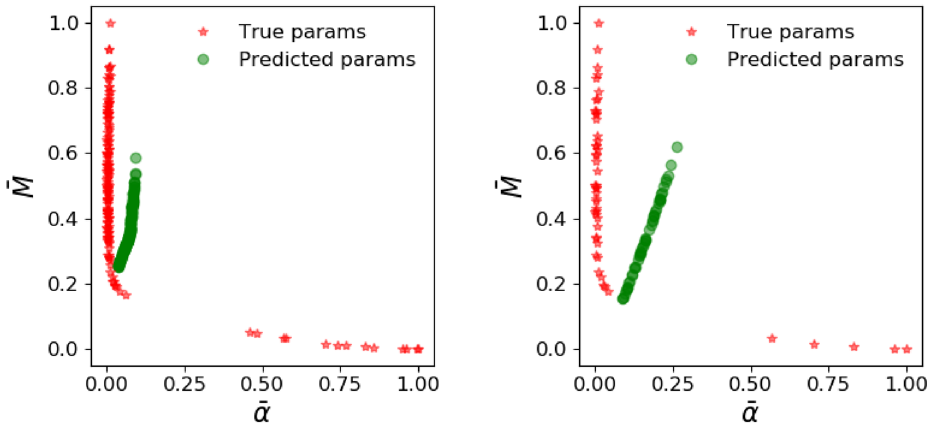
Figure 9. Parameter prediction from the ANN with production loss function (8) before (left) and after (right) transfer learning. The training with synthetic data from the Patzek reduced-order model is not geared to predict the parameters accurately, but instead to match the production.